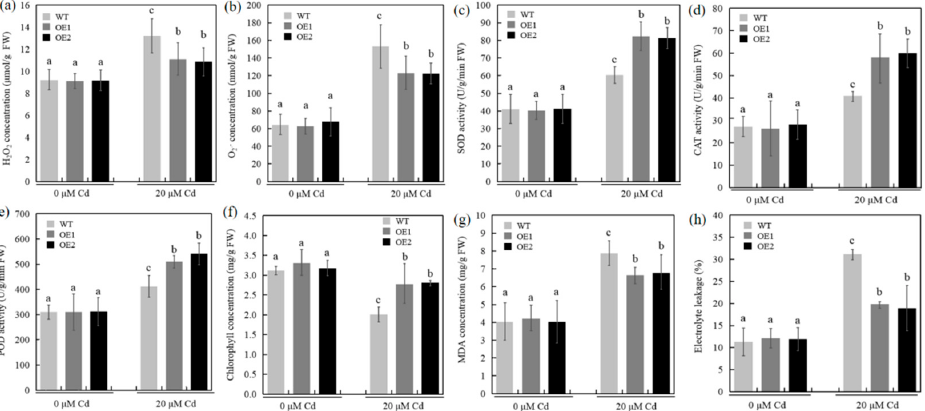
Figure 4. ( a ) H 2 O 2 , ( b ) O2 • − , ( c ) SOD, ( d ) CAT, ( e ) POD, ( f ) chlorophyll, ( g ) MDA, and ( h ) electrolyte leakage in WT and transgenic plants. H 2 O 2 , O2 • − , SOD, CAT, POD, MDA, and electrolyte